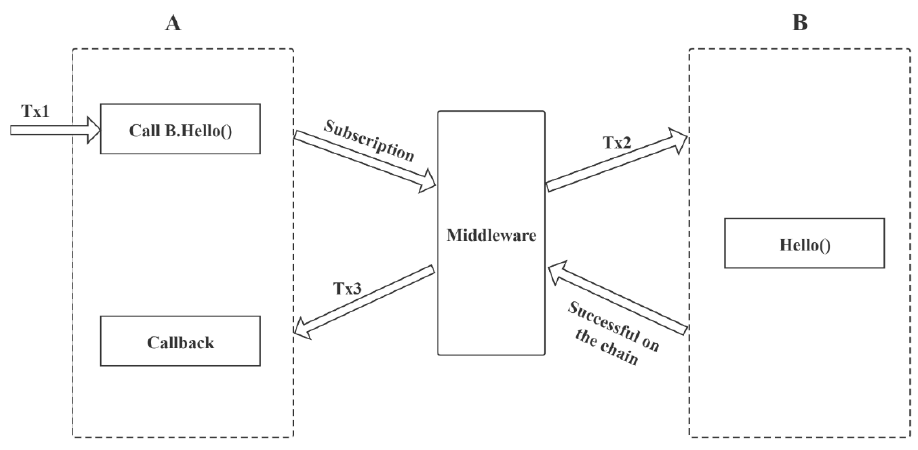
Figure 4. Cross-chain smart contract data information interaction process.